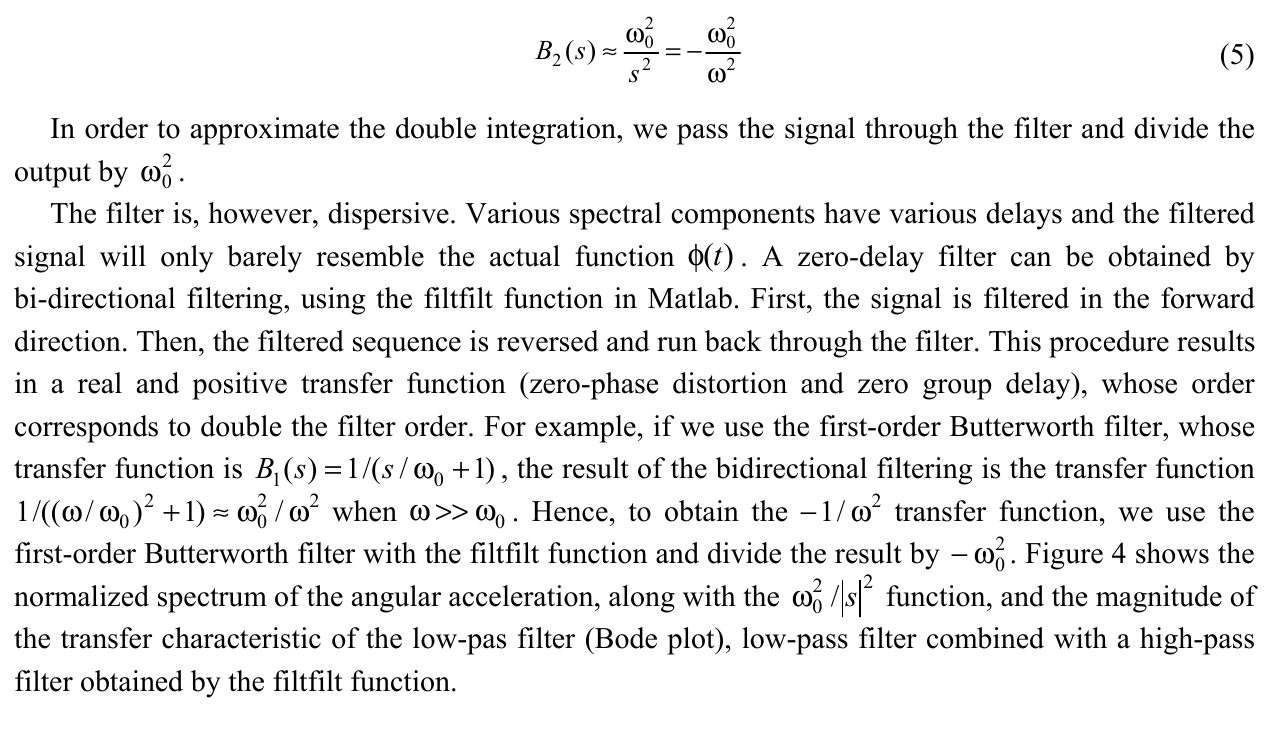
Figure 4. Normalized spectrum of the angular acceleration for knee angle (shown in / s ω , transfer function of a second-order Figure 3) and magnitudes of the function 22 0 Butterworth low-pass filter (lpf), and function of this low-pass filter combined with a high-pass filter (lpf +